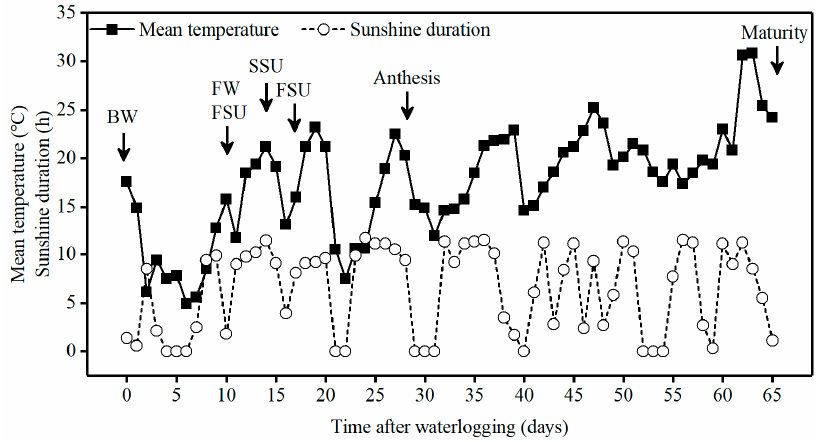
Figure 1. Mean temperature and sunshine duration per day from the beginning of the waterlogging treatment to the maturity stage. Arrows indicate treatment times and the anthesis and maturity stages, where BW and FW refer to the beginning and the finishing of the waterlogging treatment, respectively; FSU stands for the time of foliar spray of the urea solution; and SSU is the time of soil surface spray of the urea solution.